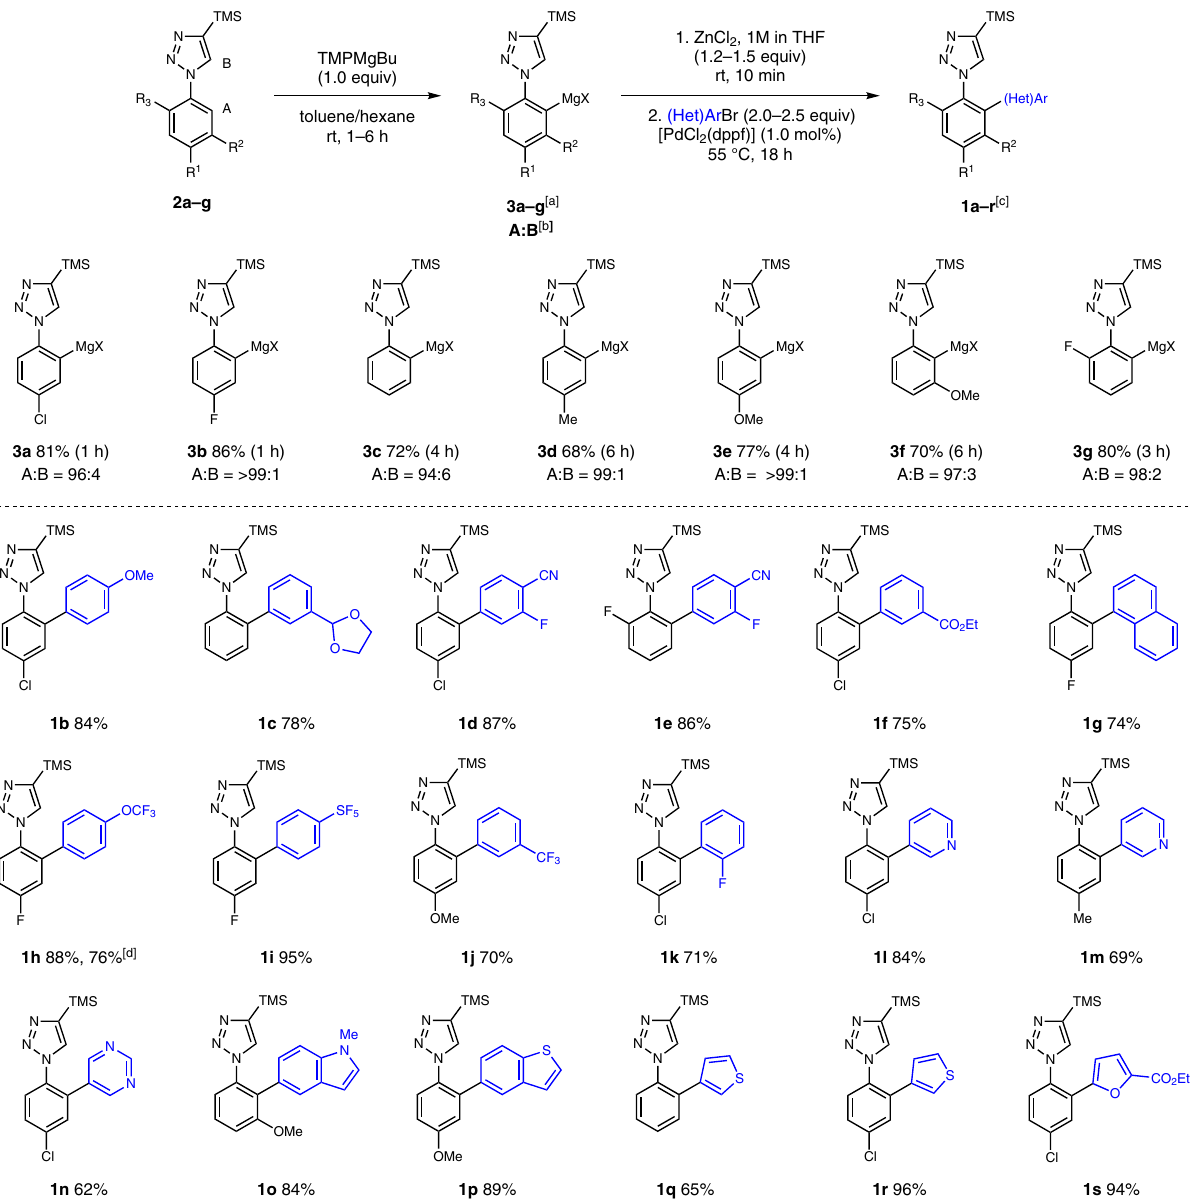
Fig. 3 Metalation of various aryl triazole derivatives and scope of the subsequent palladium-catalyzed cross-coupling. Experiments were performed on a 0.5 mmol scale. [a] Metalation yields were determined by 1 H-NMR analysis of D 2 O-quenched reaction aliquots. Metalation time in brackets. [b] Metalation ratio in [%] between regioisomers of type A and B. [c] All yields refer to isolated compounds. [d] Reaction performed on a 5 mmol